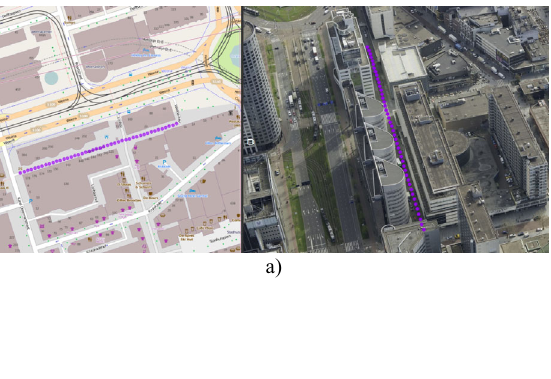
Figure 9. Convergence of pose corrections of the MMS panoramic image to zero values.